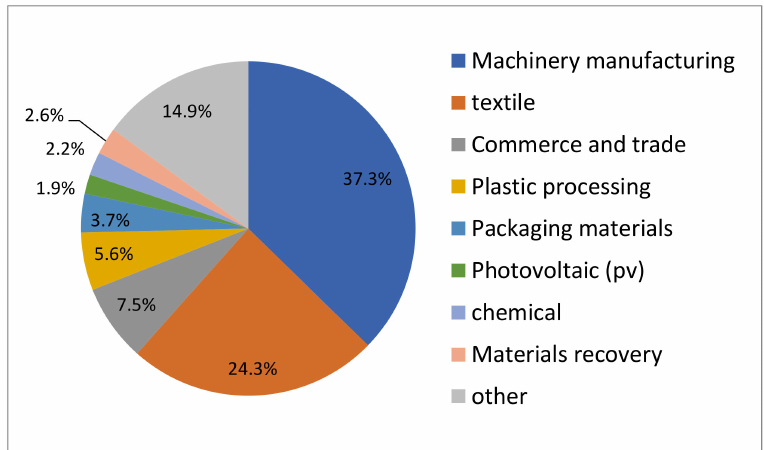
Figure 3. Classification and analysis of industrial enterprises around the landfill during the past 30 years.